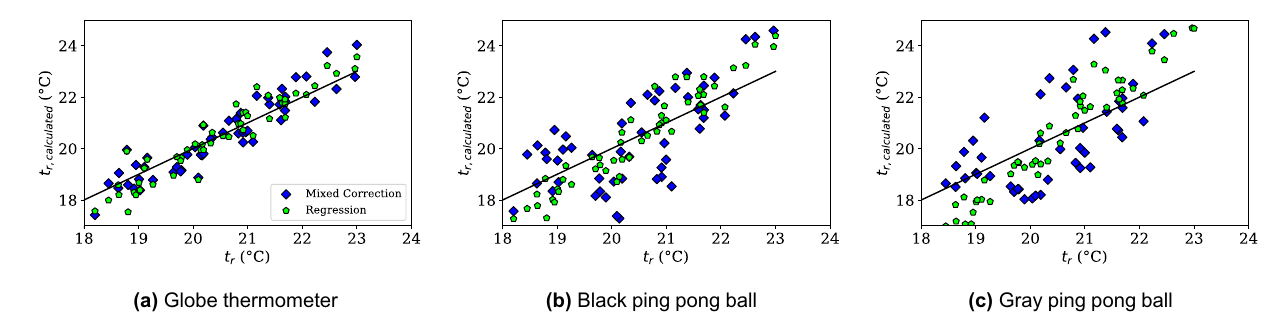
t g to predict t r . The results of the regression for Figure 6. Bivariate linear regression using air speed and t a − the standard globe thermometer overlap well with the empirical model, however the empirical model slightly outperforms ( R 2 =0.84 versus 0.92). For the ping pong balls, the regression distribution is tighter, however the x line. R 2 =0.65 and 0.37 for the black and gray ping pong balls, respectively. slope is quite far off the y =